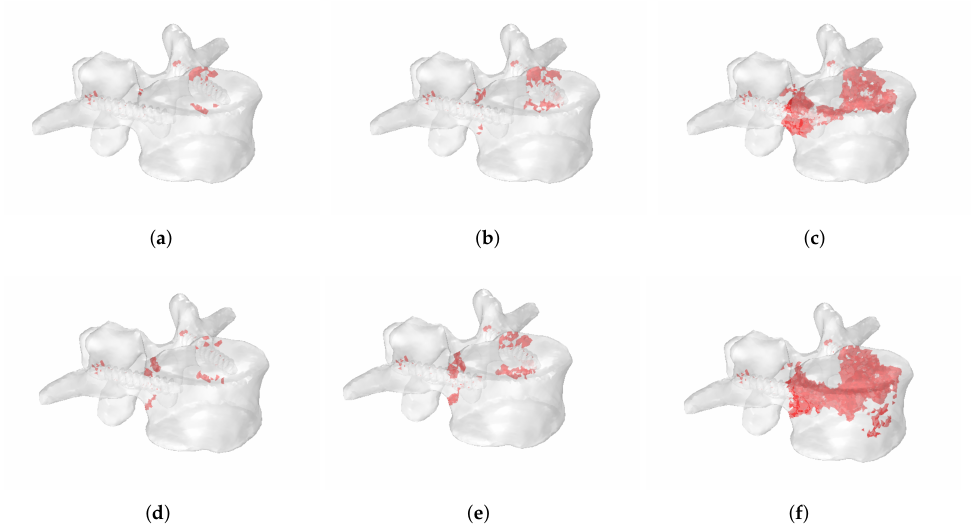
Figure 12. Progression of fracture patterns in an extension-loading condition for osteolytic lesions of 5 mm ( a – c ) and 10 mm ( d – f ) located in P1 using the stress-based criterion. Failed elements are highlighted in red.